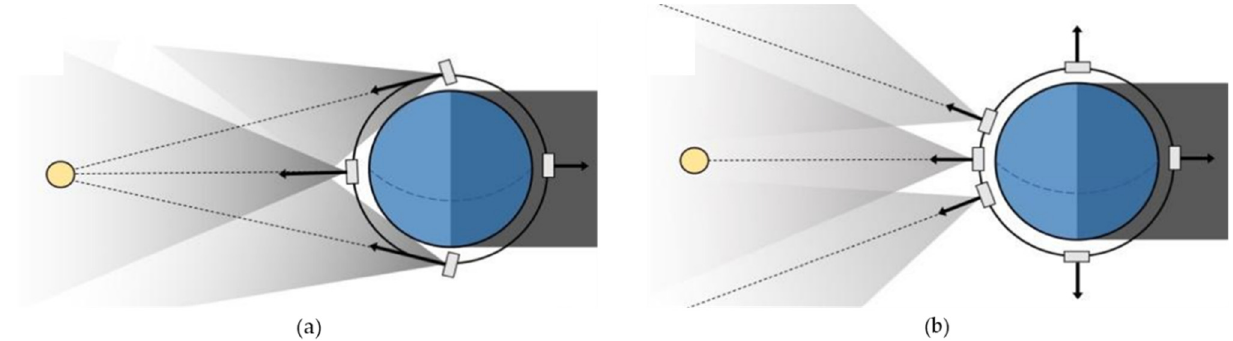
Figure 5. Pointing regime examples, depicting ( a ) sun-tracking and ( b ) zenith pointing options. ( a ) The satellite orients the antenna towards the Sun as soon as a line of sight is possible, and maintains tracking for the duration of the dayside orbit sector. ( b ) The antenna maintains a fixed zenith angle with respect to the Earth. The grey beam represents the primary antenna main lobe.